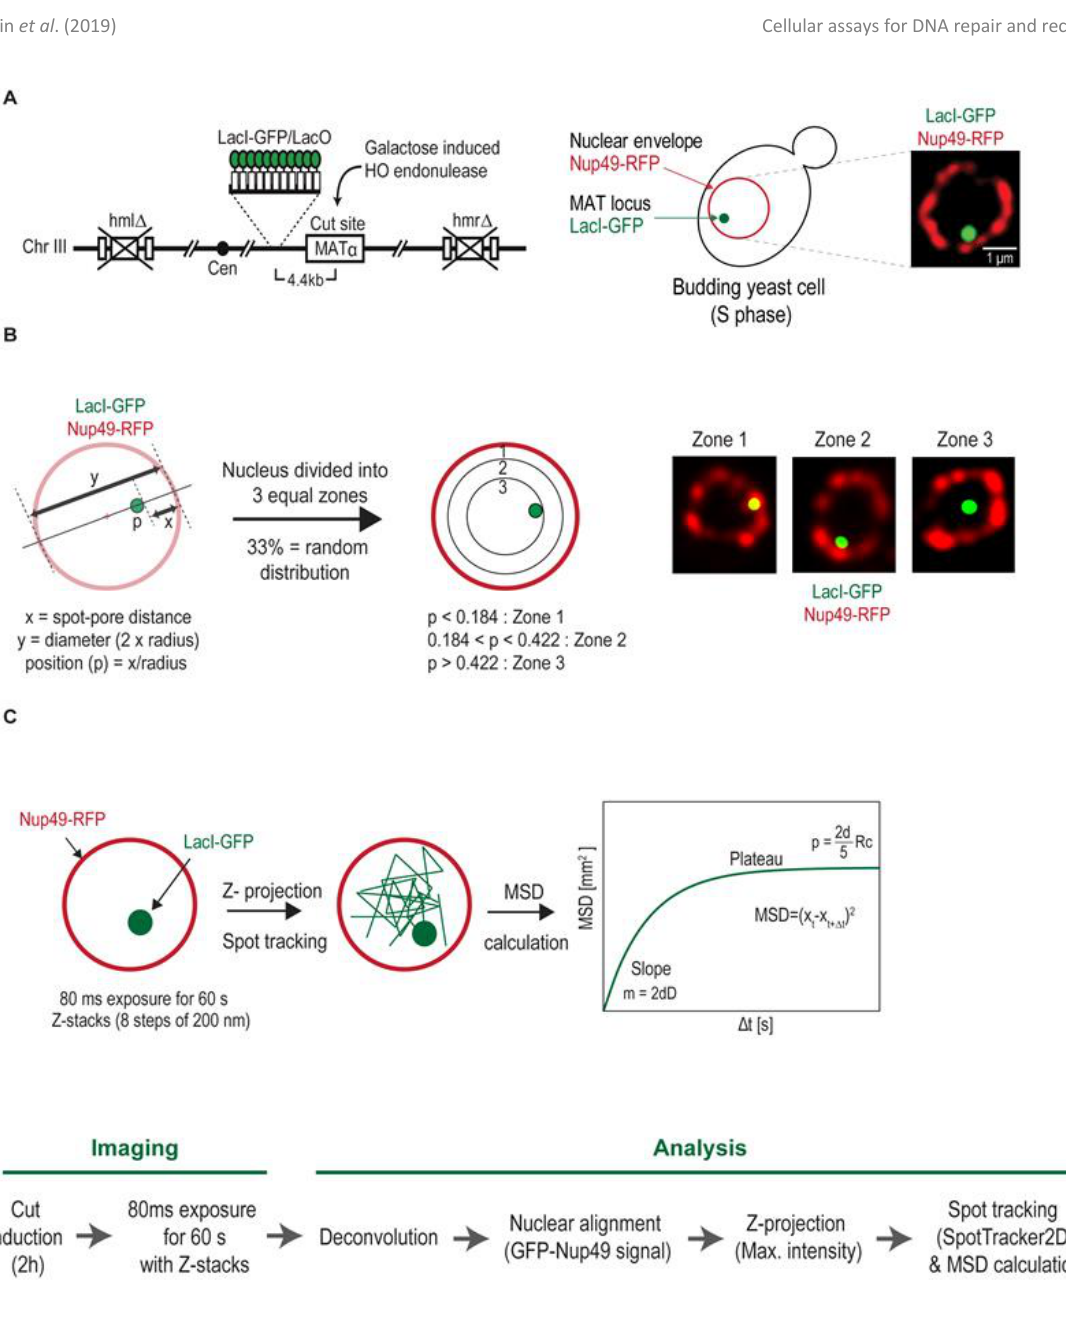
OPEN ACCESS | www.microbialcell.com